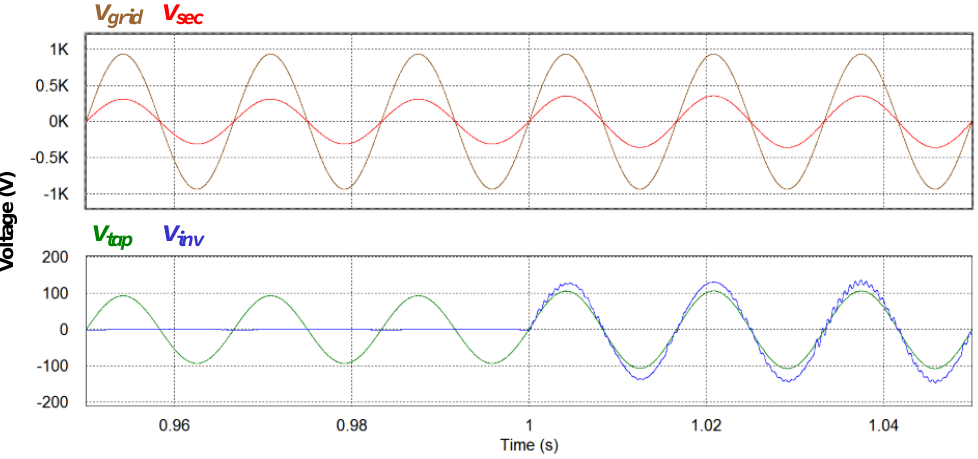
Figure 10. Simulation results of boost mode operation.